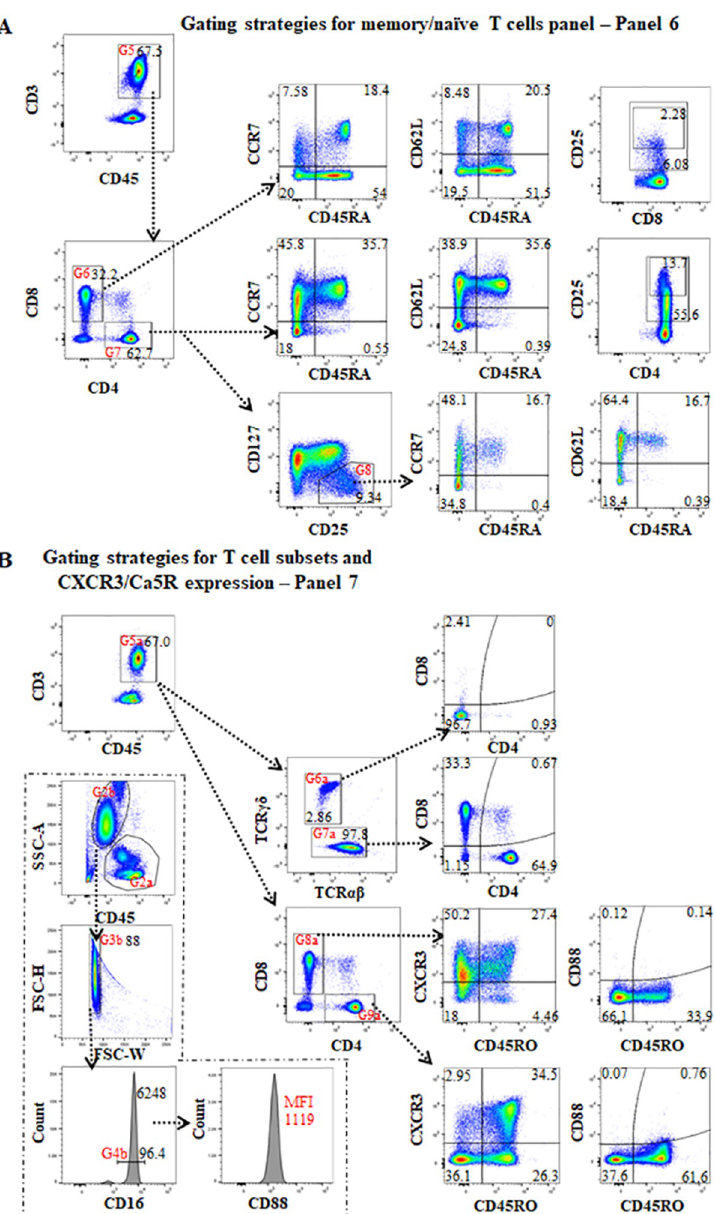
Fig 5. The gating strategies for memory and na ï ve T cell panels (panel 6), T cell subsets, and CXCR3 and Ca5R expression (panel 7). (A) For panel 6, the strategies of the first to fourth gates were the same as panel 4 (Fig 4). After gating on CD3+CD45+ T cells (G5) and then gating on CD8 T cells (G6) or CD4+ T cells (G7), CD45RA vs CCR7 and CD45RA vs CD62L identified na ï ve (CD45RA+CCR7+/CD62L+), central memory (CD45RA-CC7+/CD62L+), effector memory (CD45RA-CC7-/CD62L-) and terminal differentiated effector memory (TEMRA) (CD45RA+CC7-/ CD62L-) CD4+ or CD8+ T cells. CD8 vs CD25 and CD4 vs CD25 can be used to estimate the ratio of CD8+CD25+, CD8+CD25+bright, CD4+CD25+ and CD4+CD25+bright T cells respectively. To identify Treg cells, the initial gate is on CD4+ T cells (G7), then evaluation of CD25 vs CD127 expression with the CD25+CD127-/dim population defined as Treg cells. Further gating on these Tregs (G8), and gating on CD45RA vs CCR7 and CD45RA vs CD62L separated CD45RA+CCR7+/CD62L+ na ï ve-Tregs from CD45RA-CCR7+/CD62L+ and CD45RA-CCR7-/CD62L- activated Tregs. (B) For panel 7, the first part focuses on CD3+ T cells. The first to fourth gates (G1-G4) were the same as in panel 6. After gating on CD3+CD45+ T cells (G5a), TCR αβ vs TCR γδ showed the proportion of TCR αβ and TCR γδ in CD3+ T cells. Gating on TCR γδ (G6a) and TCR αβ (G7a), CD4 vs CD8 showed the proportion of CD4+, CD8+, CD4-CD8- and/or CD4+CD8+ T cells on these two TCR cell-populations. Additionally, after gating on CD3+CD45 + T cells (G5a), then gating on CD8+ (G8a) or CD4+ (G9a) T cells on CD4 vs CD8, expressions of CXCR3 and